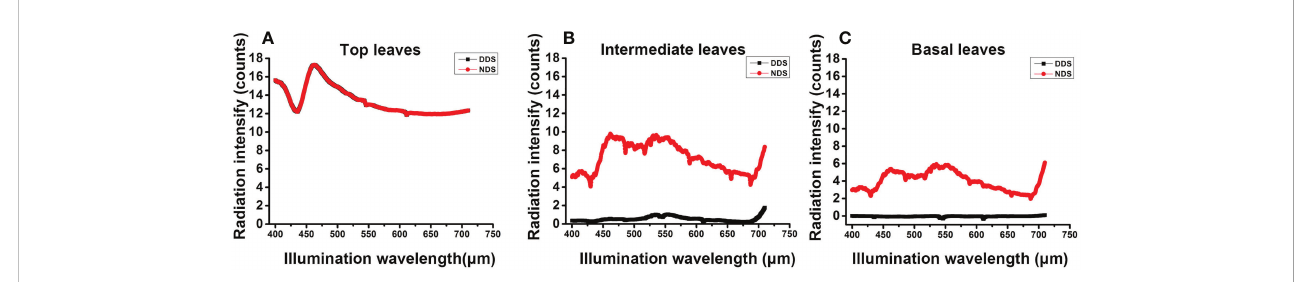
FIGURE 2 Radiation intensity declined under DDS. (A) The radiation intensity showed no difference at the top leaves at 72 DAG. (B) The radiation intensity was reduced in the DDS plants in intermediate leaves at 72 DAG. (C) The radiation intensity was reduced in the DDS basal leaves at 72 DAG. Data were measure for at least three biological replicates.